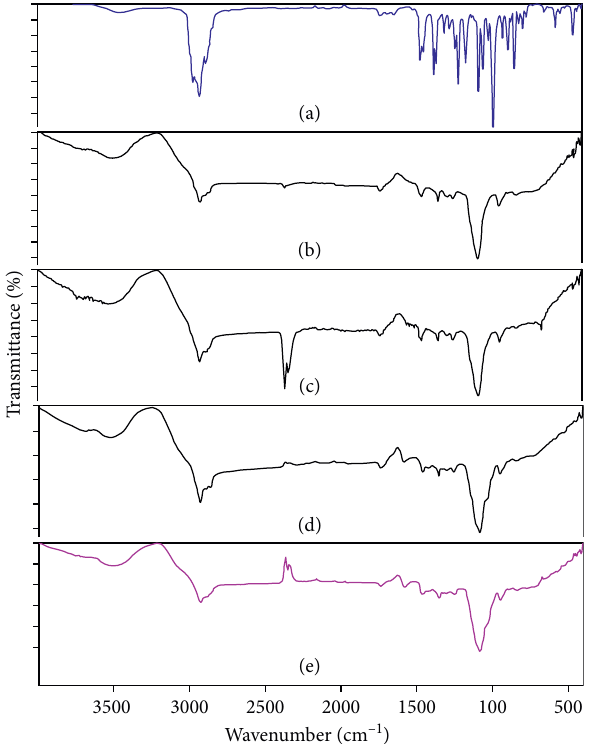
3500 Figure 2: ATR-FTIR spectra of A: E. globulus EO (EGEO), B: nanoemulsion (-oil), C: EGEO-nanoemulsion, D: nanogel (-oil), and E: